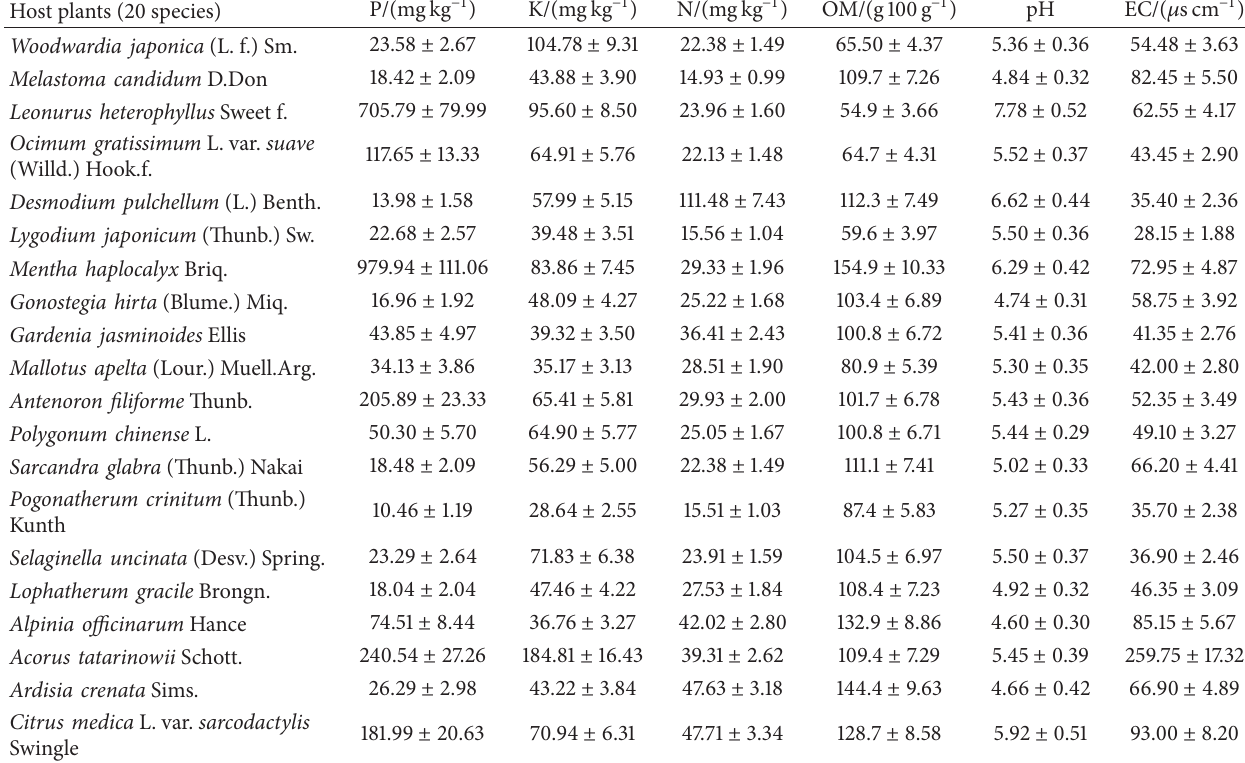
Table 2: The rhizospheric soil properties of 20 medicinal plants.